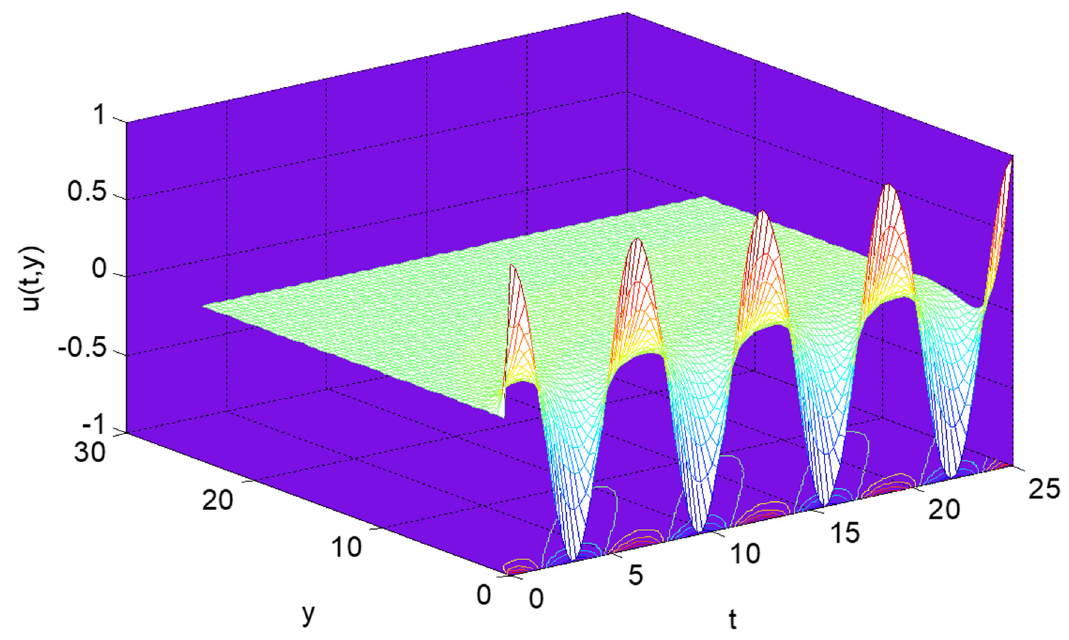
Figure 13. Surface plot with underneath contours for velocity profile of Stokes’ second problem in Quantum Calculus by the proposed scheme for spatial direction and Crank–Nicolson scheme for time direction using N y = 50, N t = 100, λ = 0.01, β = 0.01, Pr = 3, q = 0.8, L = 24, u ( t ,0 ) = cos ( t ) , θ ( t ,0 ) = sin ( t )